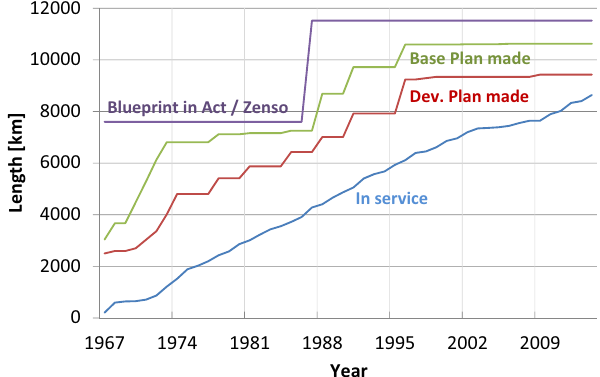
Fig. 2 Length of expressways in blue print, basic plan, construction plan and in service (Source: